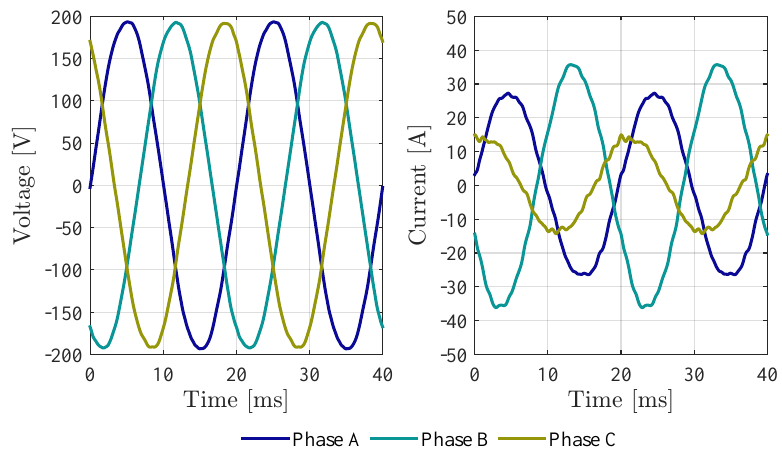
Figure 17. Voltage and current waveforms for scenario (3): mitigating the harmonics from the consumptions.